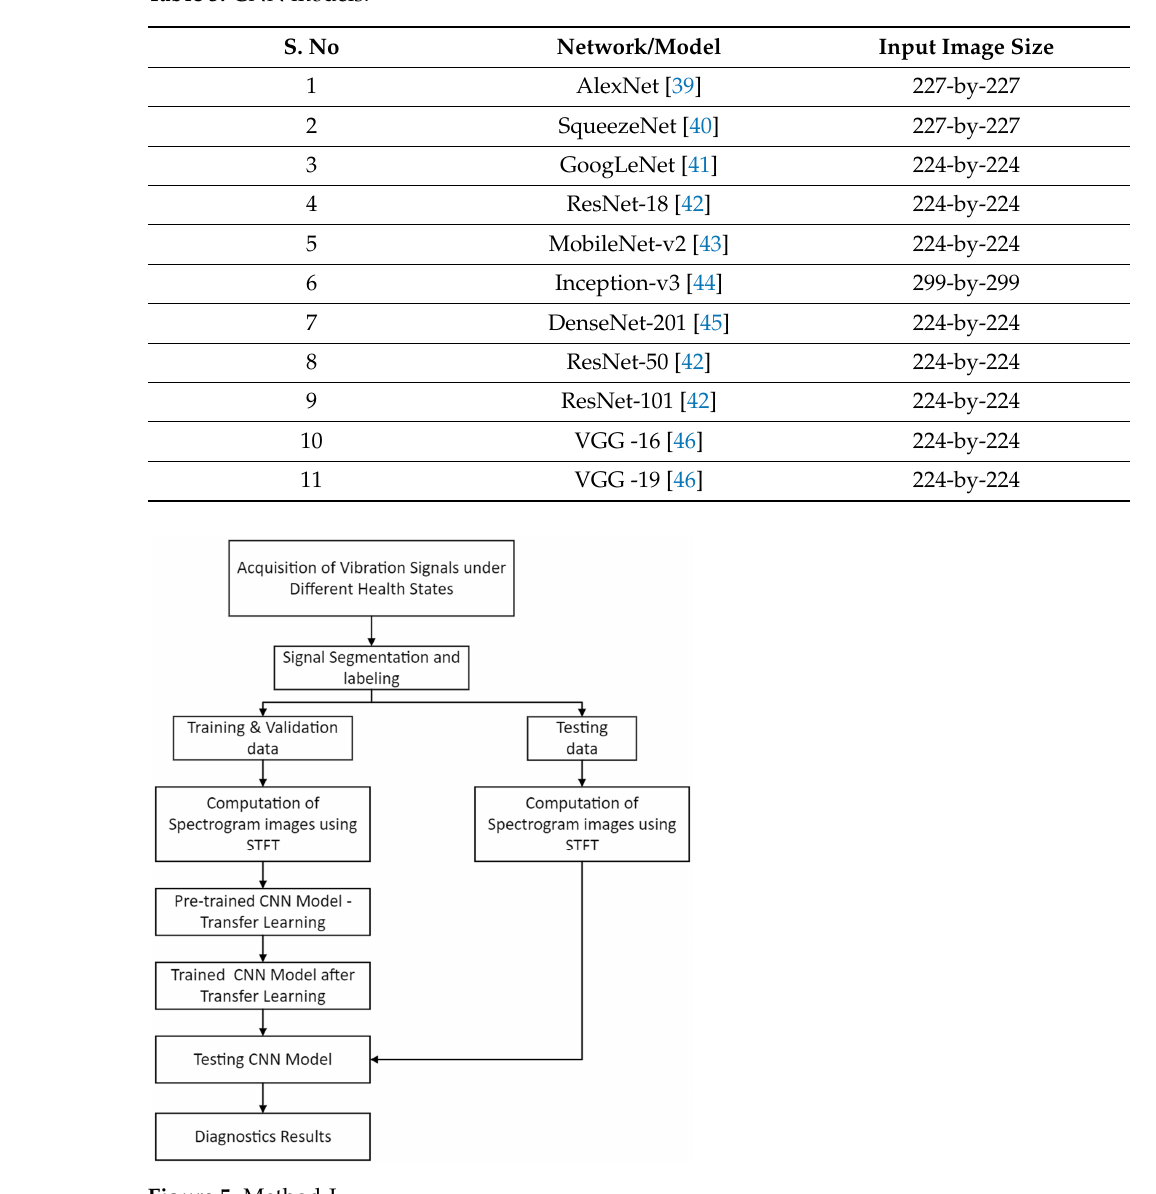
Table 3. CNN models.